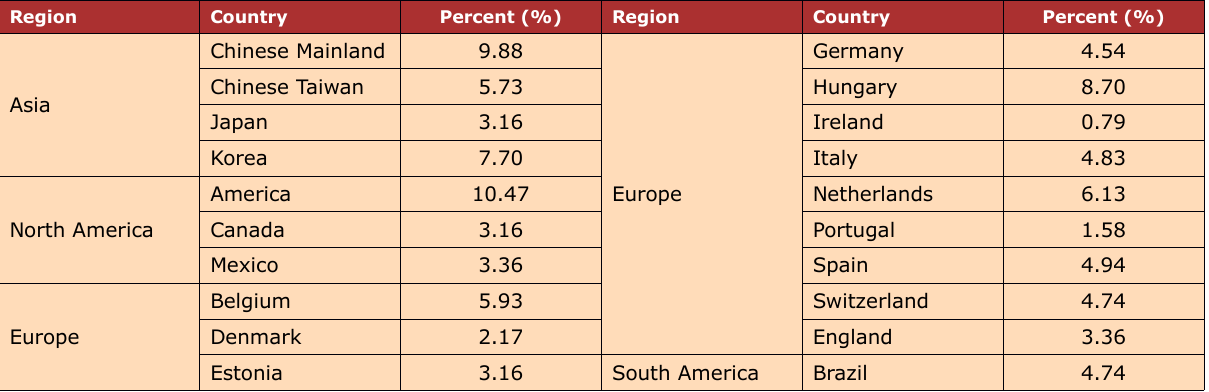
Table 2. The samples of geographical